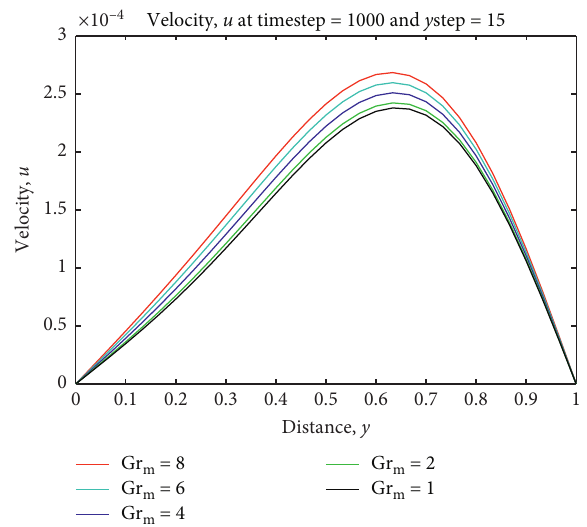
Figure 3: Effects of massGrashofnumberonprimaryvelocityprofile.